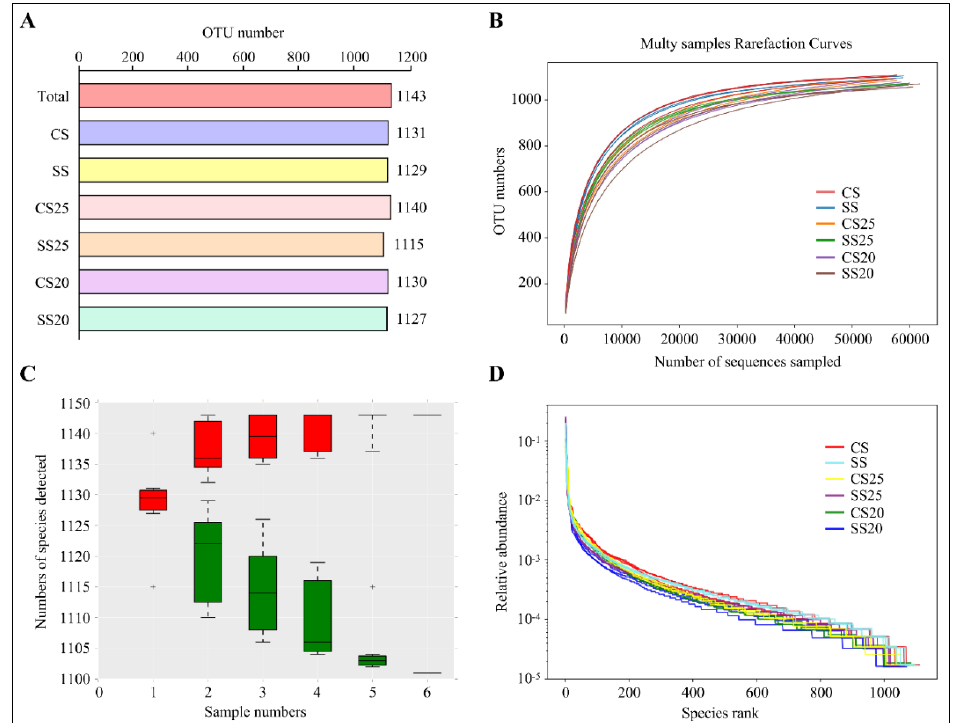
Figure 1. Overall sequence data and alpha diversity analysis. ( A ) Operational taxonomic units (OTUs) of different soil groups. CS, control bulk soil; SS, salt-treated bulk soil; CS25, controlled spermosphere soil around Huayu25 (salt-resistant peanut cultivar); CS20, controlled spermosphere soil around Huayu20 (salt-susceptible peanut cultivar); SS25, salt-treated spermosphere soil around Huayu25; SS20, salt-treated spermosphere soil around Huayu20. ( B ) Rarefaction curve analysis showing the gene sequencing depth. ( C ) Species accumulation curves showing the rate of increase of new species with the increase in sample size. “+” represents extreme outliers. Single red box reflects the total number of species in the sample, and all the red boxes form the accumulation curve. The single green box reflects the number of common species in the sample, and all the green boxes form the common quantity curve. ( D ) Rank abundance curve showing the relative species abundance and evenness. The length of the polyline on the horizontal axis reflects the OTU numbers and represents the richness of the bacterial community. The flatness of the polyline reflects the evenness of the bacterial community